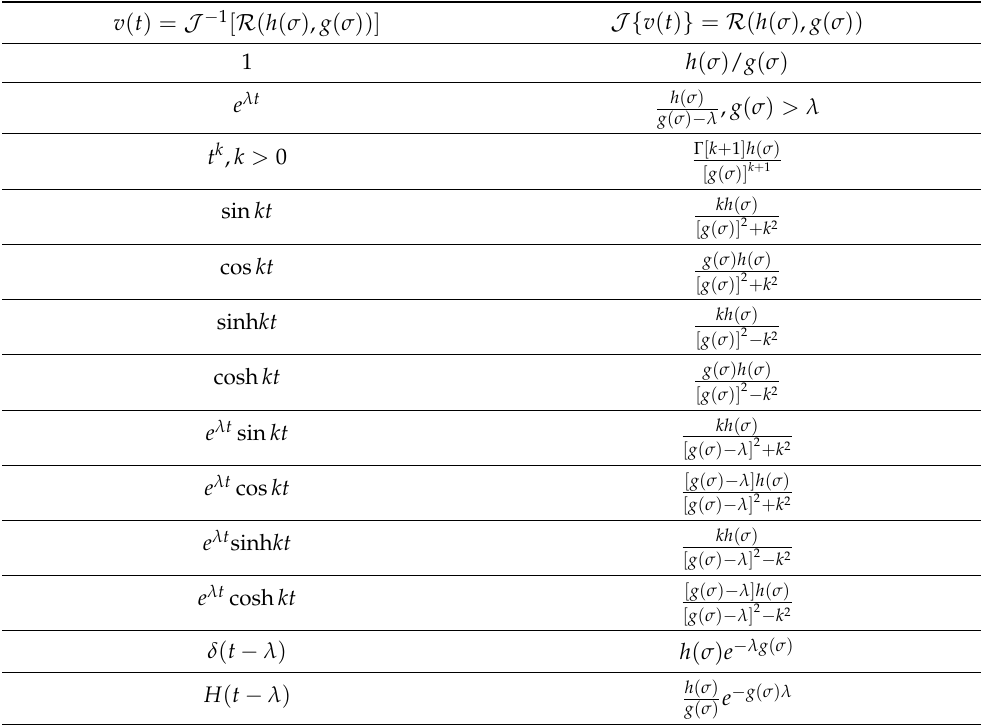
Table 1. Jafari and inverse Jafari transforms of some basic